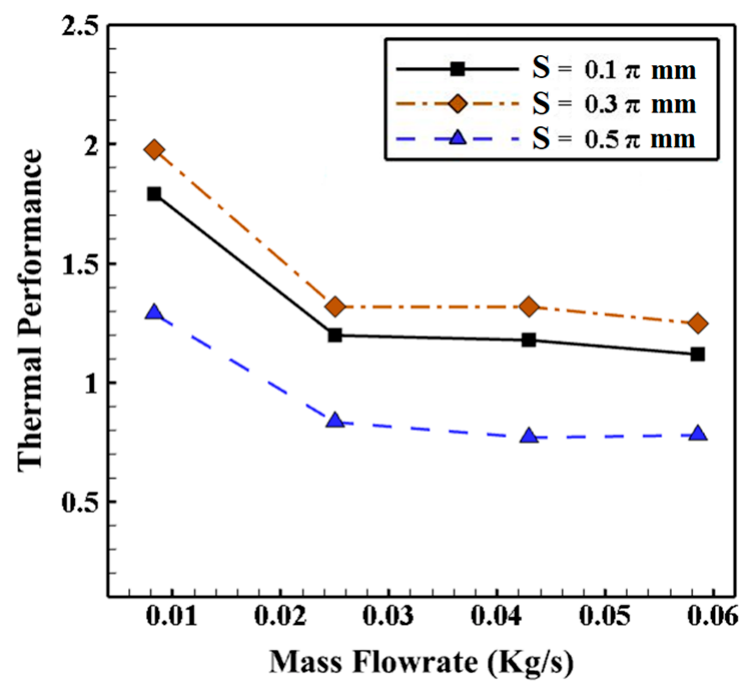
Figure 17. The deviations of thermal performance versus the mass flow rates for various positions of the proposed swirl generator at θ = 180 degrees n = 12, R 0 = 19 mm, r = 8.4 mm, L 1 = 100 mm, and m (cid:4662) = 0.043 kg/s.